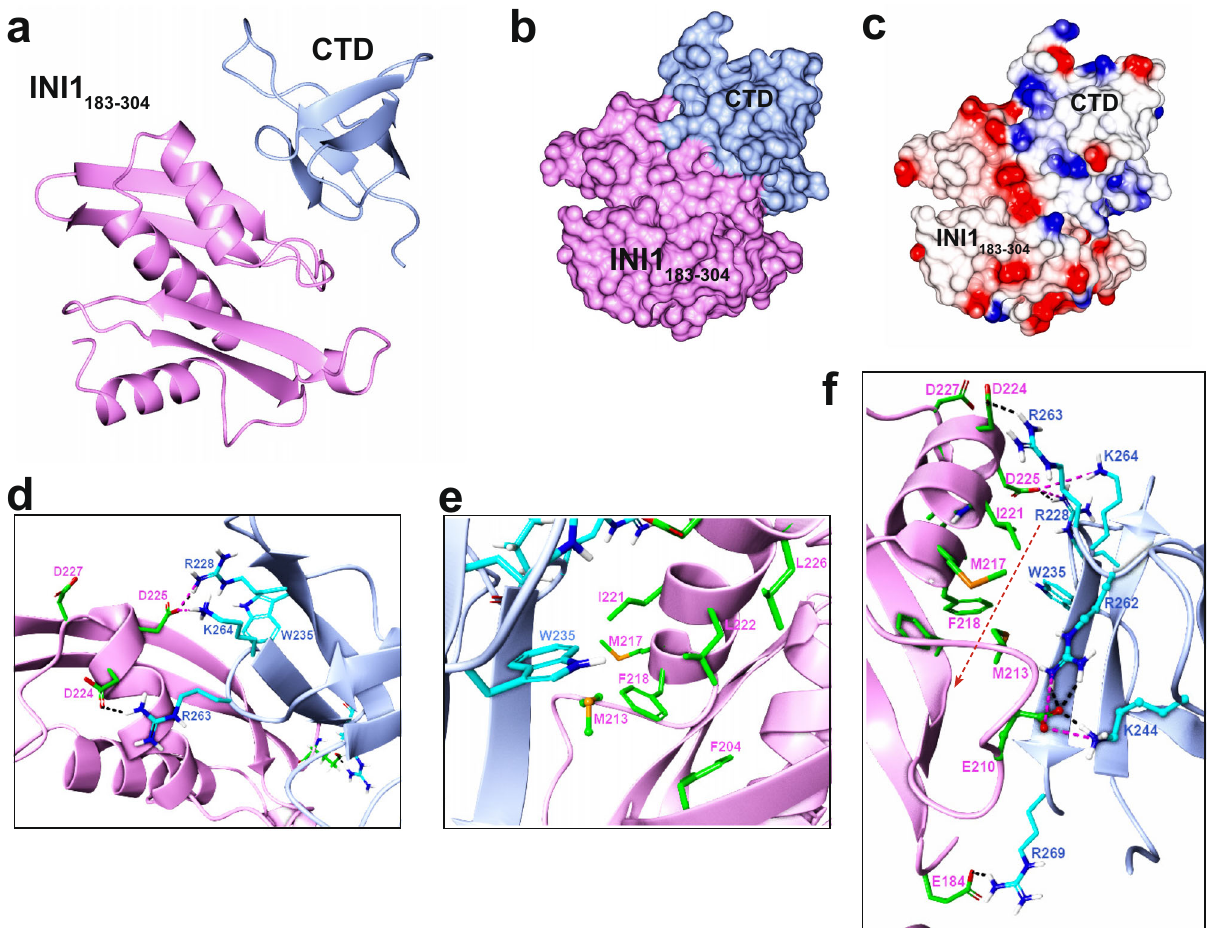
Fig. 2 Molecular docking of IN-CTD with INI1 183-304 . a Ribbon diagram of bound complex of INI1 183-304 /CTD model obtained from HADDOCK. b Surface structure of INI1 183-304 /CTD modeled complex. c Electrostatic surface; negatively charged (red), positively charged (blue) and hydrophobic (white). d – e Exploded views of the interface residues, displaying the ionic interactions ( d ), and hydrophobic non polar interactions ( e ). f Representation of the regions between INI1 183-304 /CTD showing a hydrophobic tunnel enclosed by ionic bonds at the two ends. In all panels, INI1 183-304 and its residues are shown in pink, and IN-CTD and its residues are shown in blue. Orange dotted line with arrow represents the hydrophobic tunnel. PDB fi le of this docked model is included in Supplementary Data